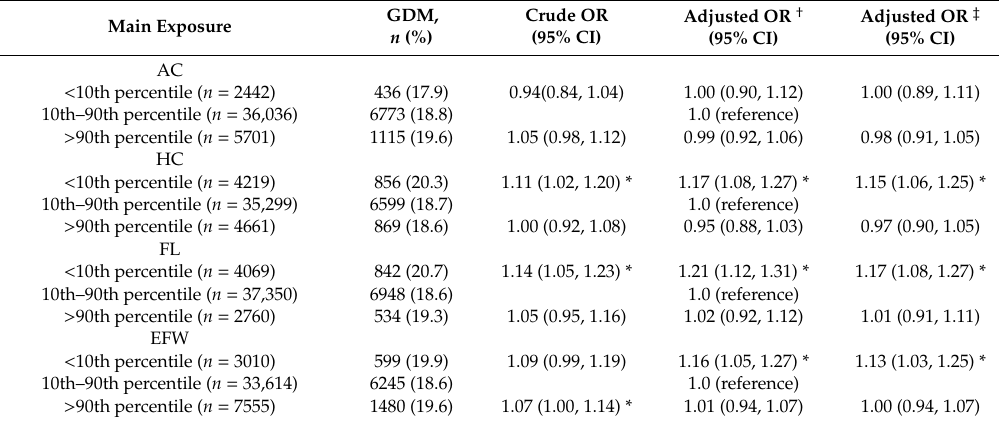
Table 2. Association between fetal biometry at 22–24 gestational weeks and subsequent gestational diabetes